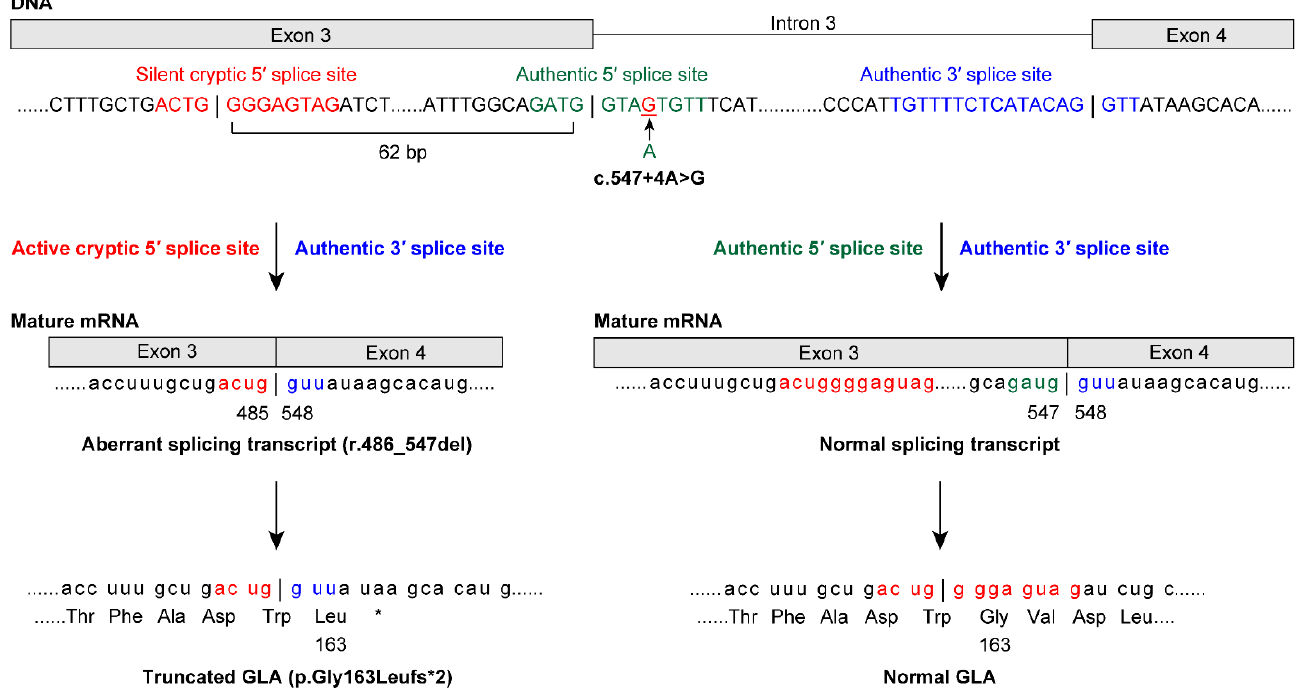
Figure 1. The 5 (cid:48) splice site (5 (cid:48) ss) variant c.547+4A>G causes normal and aberrant splicing in a male patient with late-onset Fabry disease (FD). A novel GLA variant was identified at the intronic site of the 5 (cid:48) ss at positions +3 to +6. Genomic sequencing revealed the c.547+4A>G variant, which was predicted to result in aberrant splicing using the SD-Score algorithm—a practical tool to predict splicing consequences of variants at the 5 (cid:48) ss [31]. cDNA sequencing further revealed that the authentic 5 (cid:48) ss was partially inactivated. The 5 (cid:48) ss variant acted as the authentic 5 (cid:48) ss and produced a normal transcript and GLA protein. Moreover, the variant activated the cryptic 5 (cid:48) ss at position − 62 in exon 3. This was consistent with a report showing that almost all of the major cryptic sites activated by variants are mapped within an approximate 100-nucleotide region from the authentic 5 (cid:48) ss [32]. The activated cryptic 5 (cid:48) ss caused aberrant splicing outside the GT-AG rule [33], and the activated cryptic 5 (cid:48) ss produced the aberrant transcript (r.486_547del62) and the truncated GLA protein (p.Gly163Leufs*2). Indeed, both the 5 (cid:48) ss and activated cryptic 5 (cid:48) ss were identified as candidates for 5 (cid:48) ss using GENETYX Ver.13 (Genetyx, Tokyo, Japan). In cryptic site activation, the authentic site is not always completely inactivated [32]. This mechanism explains late-onset FD in patients with the c.547+4A>G variant.